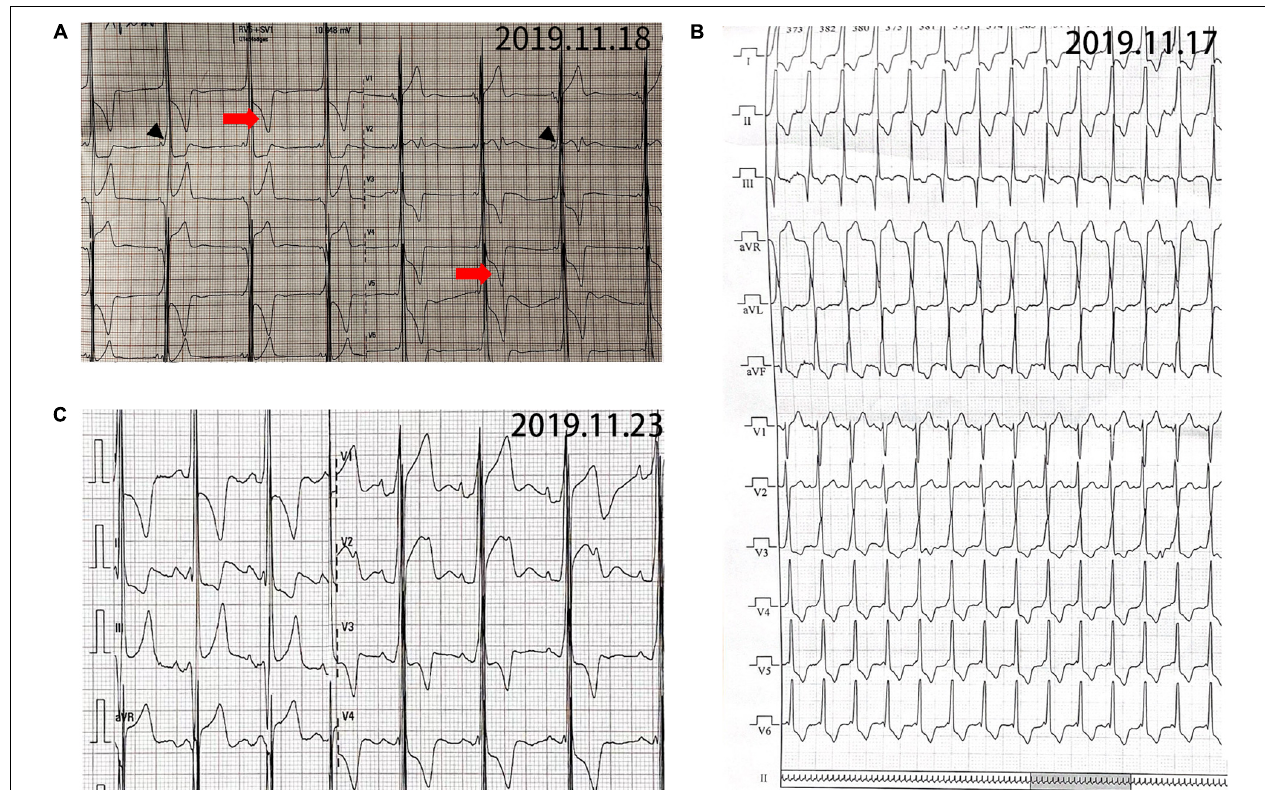
FIGURE 1 | Electrocardiogram (ECG) of patient 1. (A) ECG before operation showing sinus rhythm and 74 ms of PR interval. Delta-wave (black arrowhead) was present in II and III leads. RV 5 > 2.5 mV and RV 5 + SV l > 4.0 mV in precordial leads. RI > 1.5 mv, RaVL > 1.2 mv, RaVF > 2.0 mv with secondary ST-T changes (red arrow). (B) Narrow QRS tachycardia indicating atrioventricular reentrant tachycardia (AVRT). (C) ECG after operation showing sinus rhythm and 144 ms of PR interval. No δ wave presented, but the hypertrophic remodeling of left ventricle still existed.